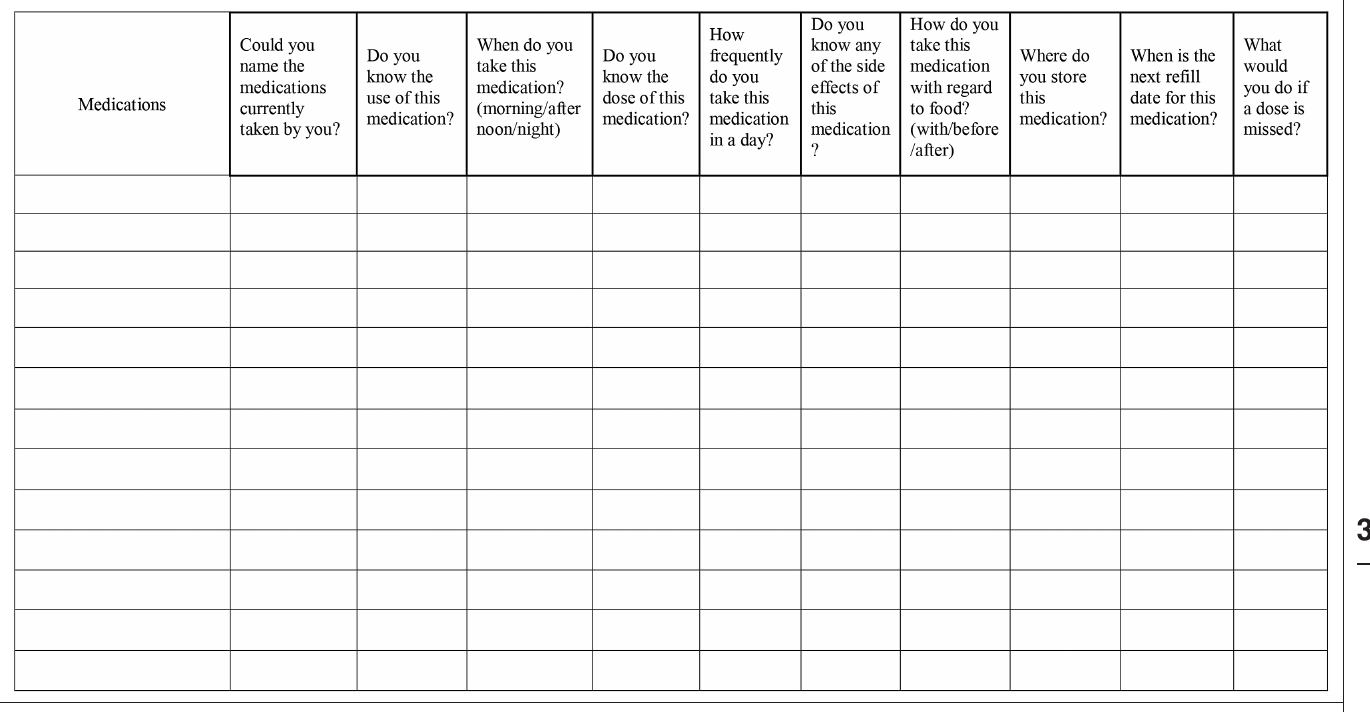
Figure 1. Medication Knowledge Assessment